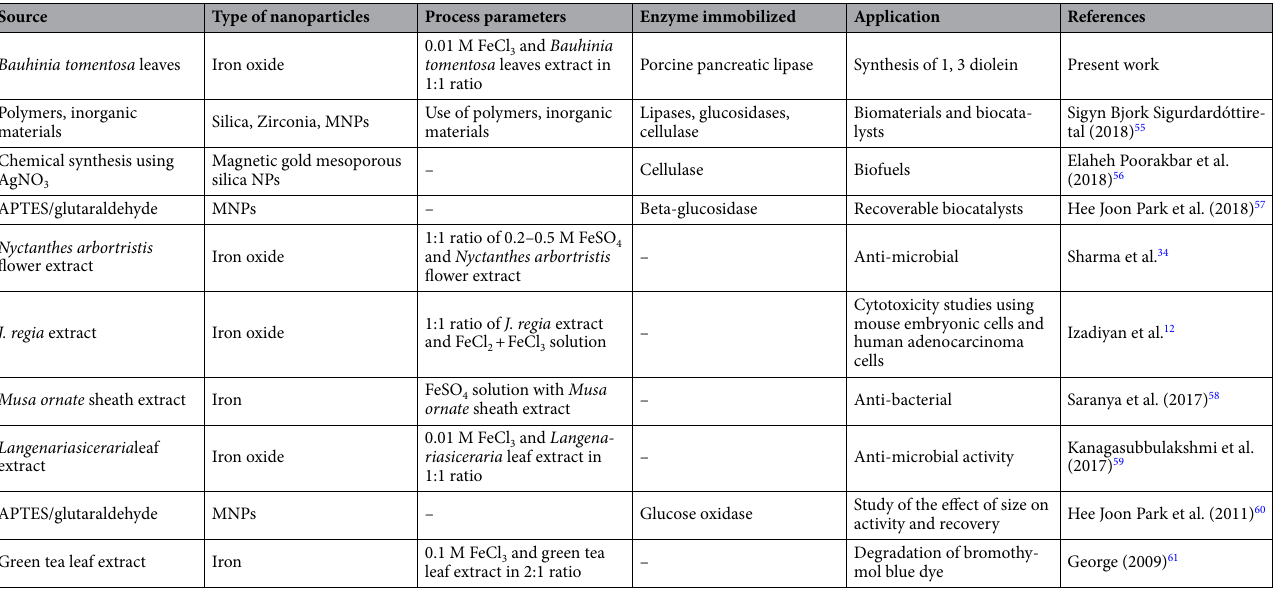
Table 1. The comparison of iron oxide nanoparticles from various sources using various methodology reported in the literature with the present